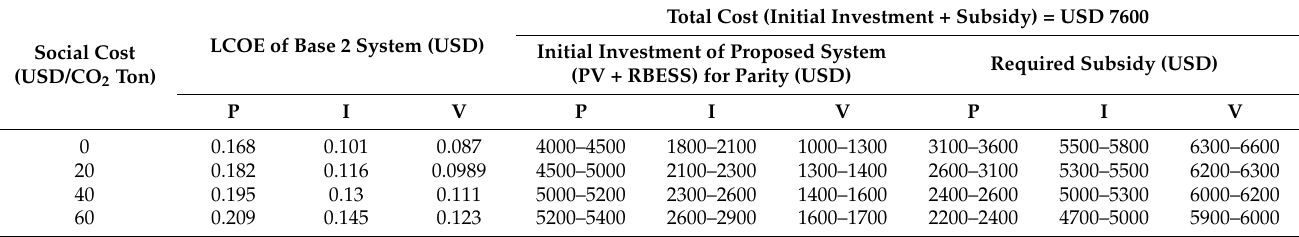
Table 19. Calculation of grid parity level in the three countries: social cost +